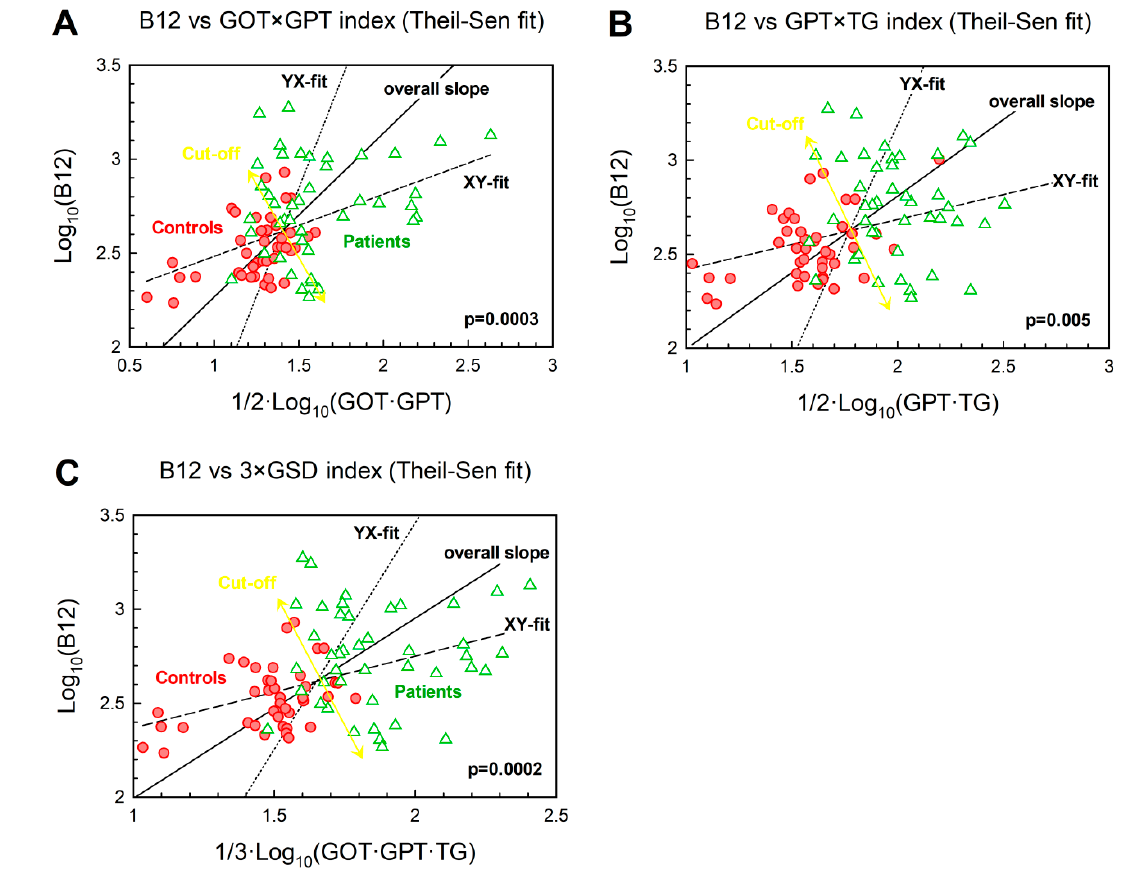
Figure 5. Correlations between the combined markers of GSD and B 12 presented in logarithmic coordinates. Panels show ( A ) B 12 vs. GOT & GPT; ( B ) B 12 vs. GOT & TG; ( C ) B 12 vs. GOT, GPT & TG. Data from cohorts of controls and GSD patients are notated as red circles and green triangles, respectively. All other notations are as in legend to Figure 4.